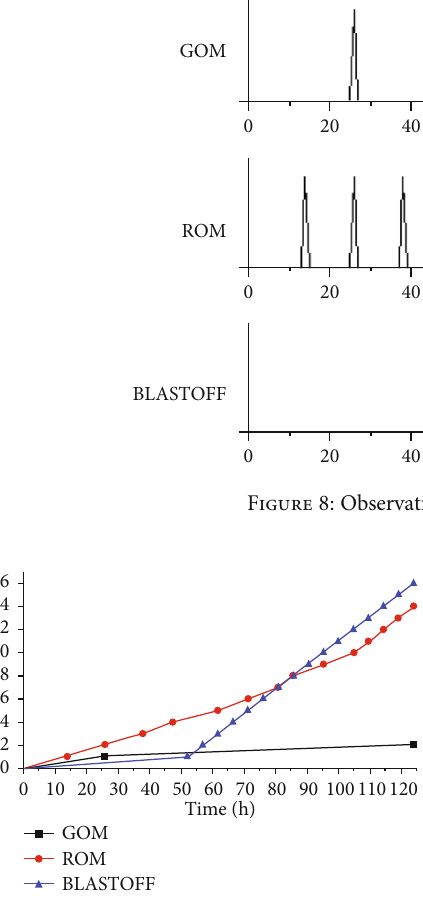
Figure 9: Total observation numbers of di ff erent